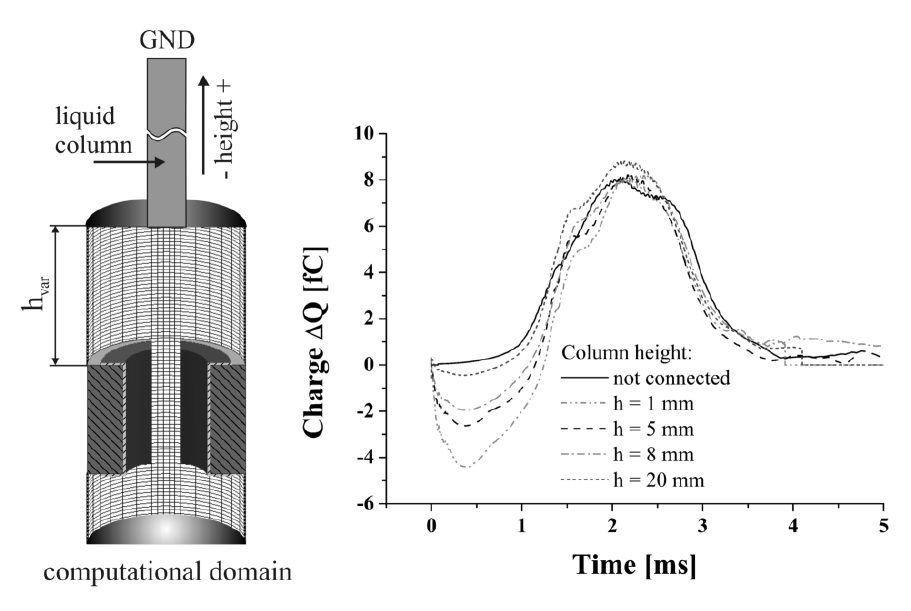
Figure 8. Investigation of the influence of the capacitive coupling effect by variations of the liquid column height.